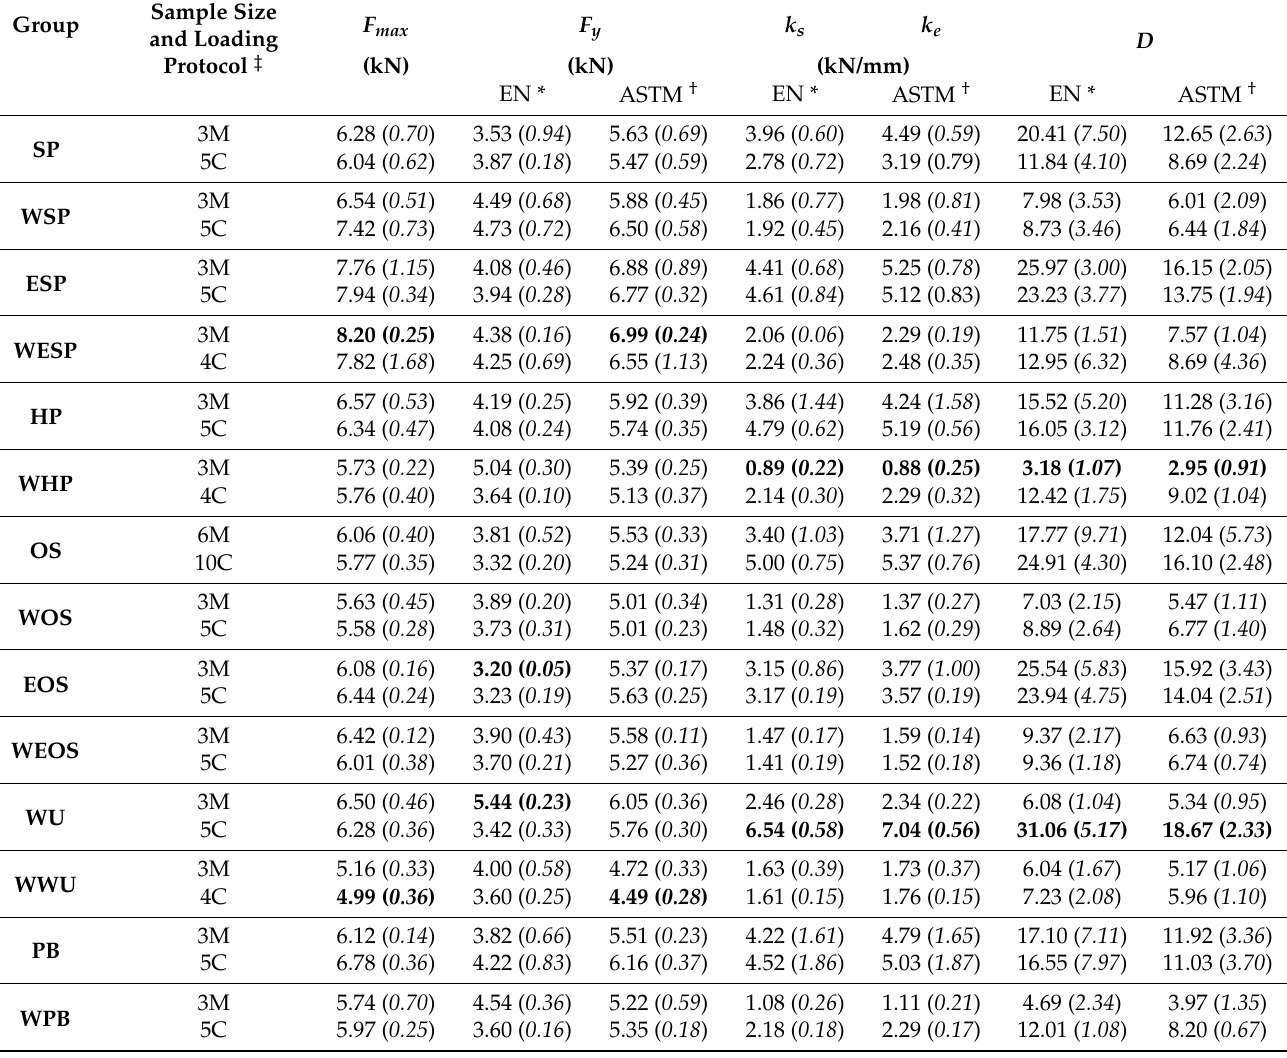
Table 3. Structural performance characteristics of STCs by group and loading